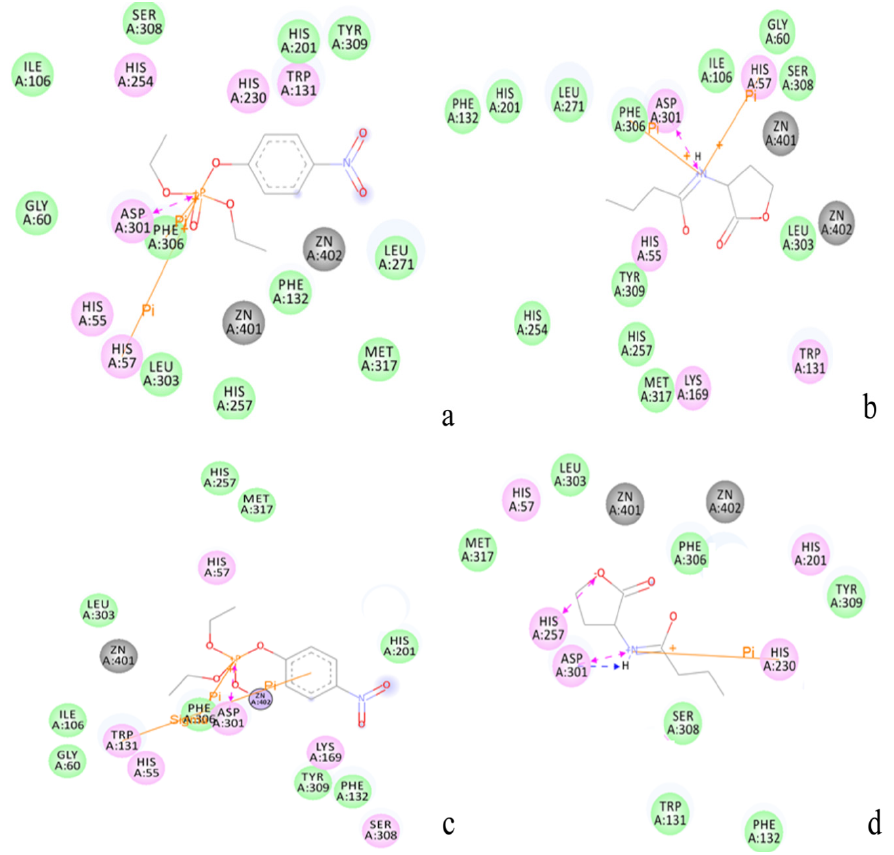
Figure 6. ( a ) The active residue of WT PTE around paraoxon calculated by the Discovery Studio 3.5 client. Residue interaction: pink: eletrostatic, green: van der Waals, blue: water interaction, black: metal interaction; ( b ) The active residue of loop 7-2/H254R variant around paraoxon; ( c ) The active residue of WT PTE around C4-HSL (residue number used PTE); ( d ) The active residue of loop 7-2/H254R variant around